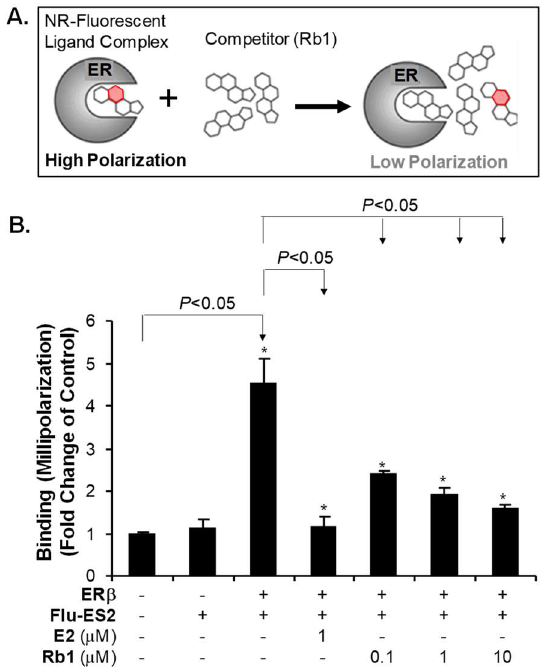
Figure 7. Estrogen receptor (ER) competitor assay. ( A ) Principle of the assay (Invitrogen kit); ( B ) Ginsenoside Rb1 binding assay. E2 was used as a positive control. ER-β binding data were standardized with the untreated control group as 1. Student’s t -test was used to compare the control with the treated groups or between two groups. * p < 0.05. n = 3/group. Three concentrations of Rb1 showed effective binding capability to ER-β. E2 (estradiol).